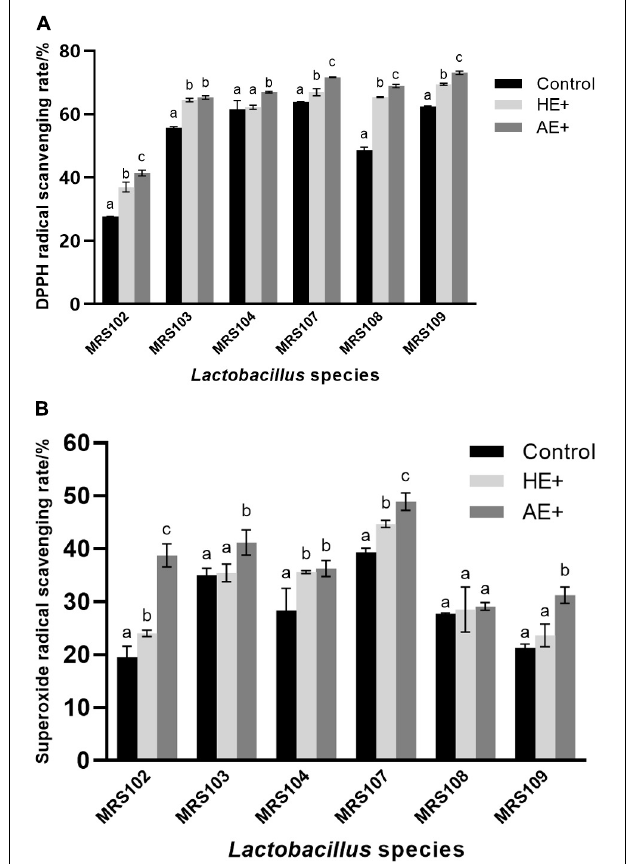
FIGURE 2 | The antioxidant analysis of Lactobacillus strains was evaluated using DPPH free radical scavenging ability (A) and superoxide anion free radical scavenging ability (B) on the addition of Euglena powders (AE+ and HE+).